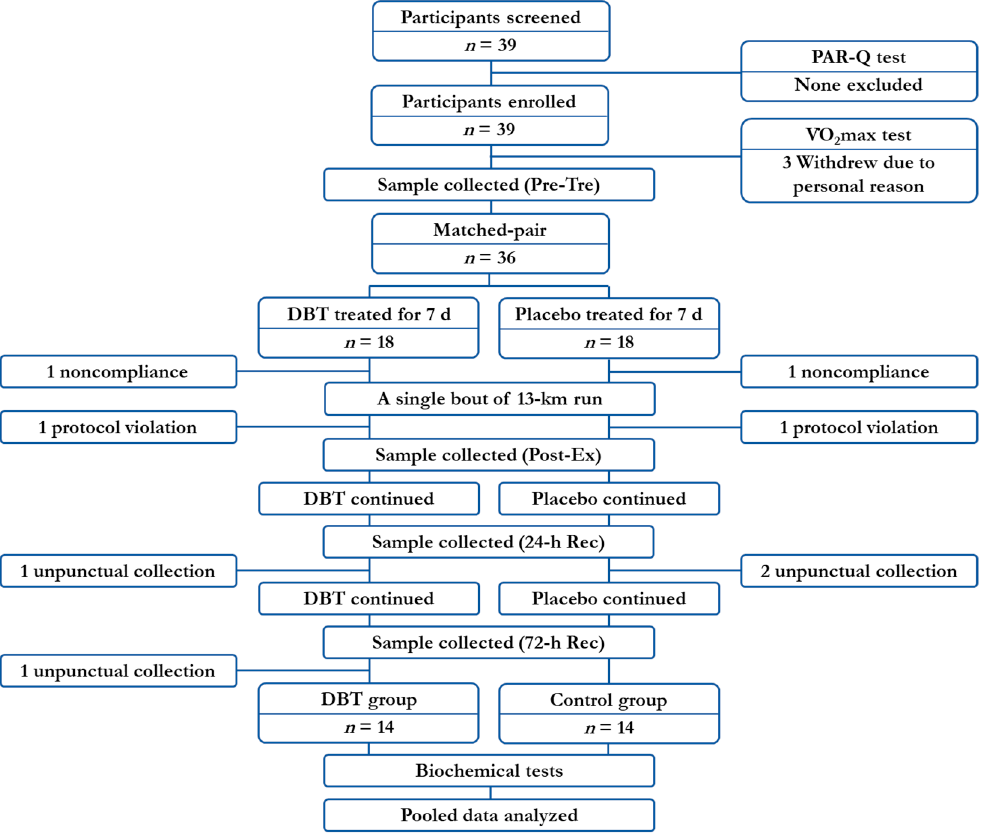
Figure 1. Flowchart of participant enrollment, allocation, and treatment.